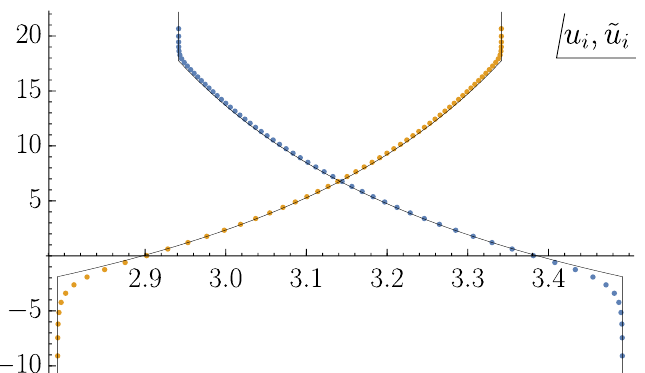
Figure 1 . The solution to the BAE for (cid:1) a = f 0 : 4 ; 0 : 5 ; 0 : 7 ; 2 (cid:25) (cid:0) 1 : 6 g and N = 60. The solid lines correspond to the leading order expression obtained in [7].